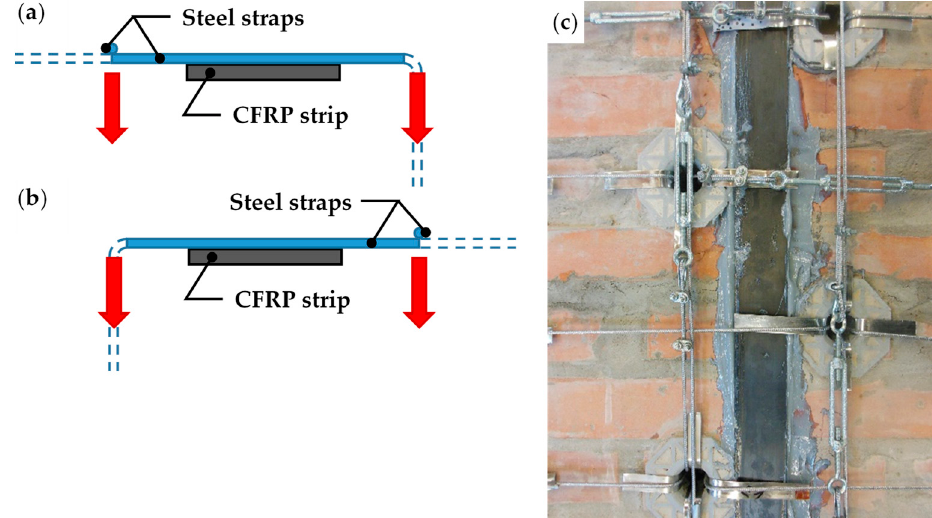
Figure 43. Load patterns of the CFPR strips: ( a ) cross-section view of the longitudinal strap on the left of the CFRP strip (not to scale); ( b ) cross-section view of the longitudinal strap on the right of the CFRP strip (not to scale); and ( c ) scheme sequence a, b, a, b on the strapped specimen.